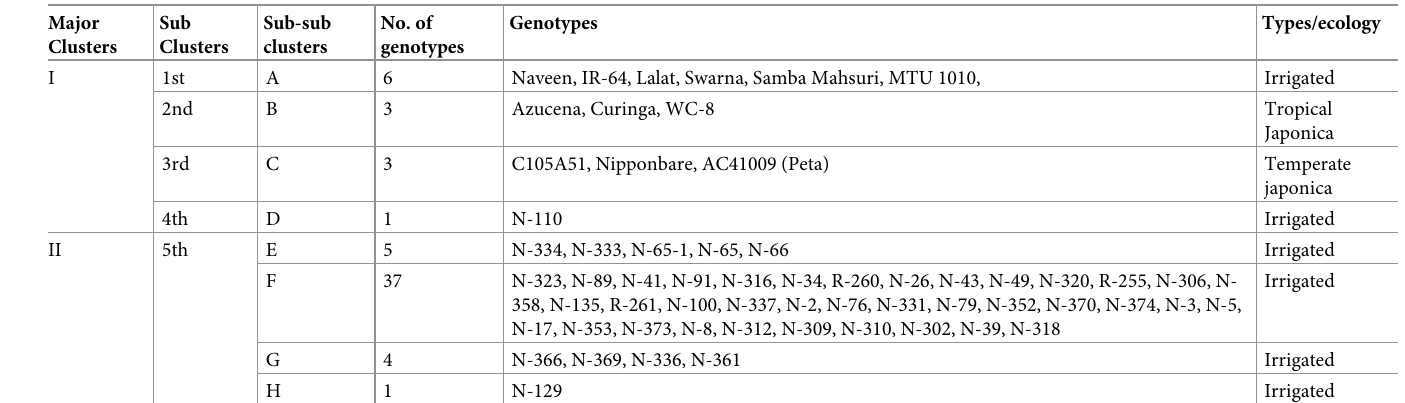
Table 3. Grouping of 60 genotypes based on the UPGMA